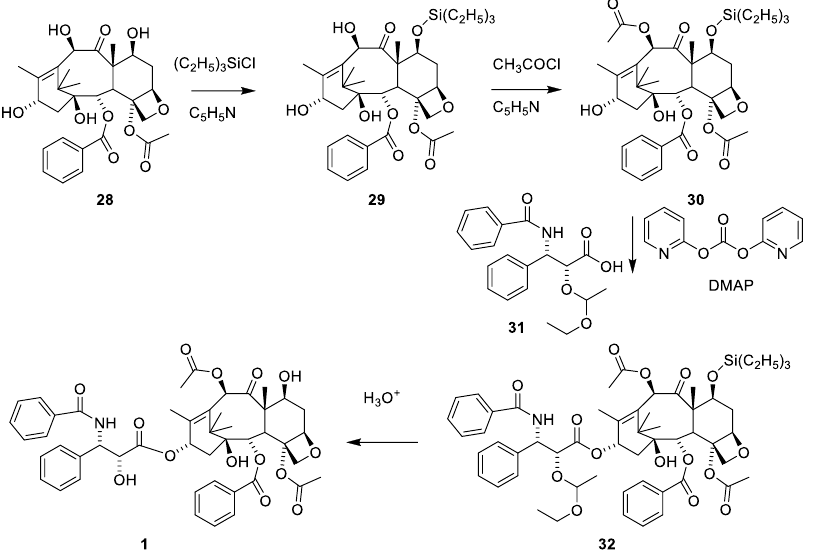
Figure 10. Semi-synthetic synthesis of paclitaxel ( 1 ) from the easy available 10-deacetylbaccatin III ( 28 ) to give paclitaxel in 4 steps [50]. DMAP dimethylaminopyridine.